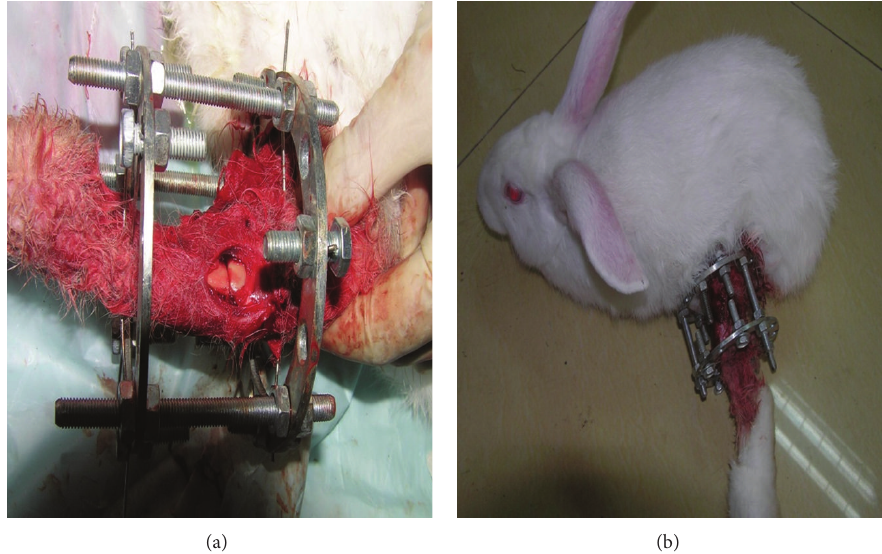
Figure 1: The animal model of rabbit tibia elongation ((a) osteotomy in the tibia and (b) the situation of rabbit after the osteotomy